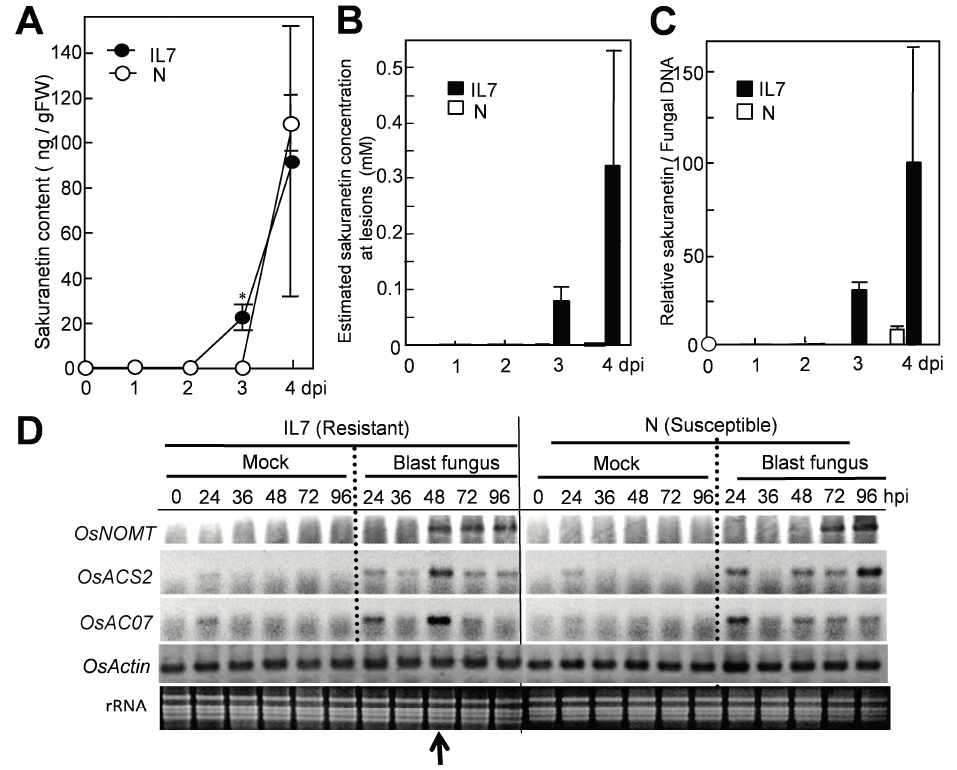
Figure 1. Increase in sakuranetin and transcript of NOMT in resistant IL7 and susceptible N rice lines after inoculation with blast fungus. ( A ) Sakuranetin content in leaves; ( B ) Estimated sakuranetin concentration at lesions; ( C ) Relative content of sakuranetin/fungal DNA; ( D ) RT-PCR analysis on a sakuranetin biosynthesis gene OsNOMT for naringenin 7 -O -methyltransferase and HR-inducible control genes OsACS2 and OsACO7 in rice leaves after mock- or blast-inoculation according to Iwai et al. [13]. Arrow indicates the time of HR lesion visualization. Asterisks indicate a significant difference between inoculated N and IL7 leaves at 3 dpi (Student’s paired t test: p < 0.01). gFW: g fresh leaf weight. dpi: Day post inoculation. hpi: Hour post inoculation. Data are means ± standard deviation (SD) from independent three samples for Figure